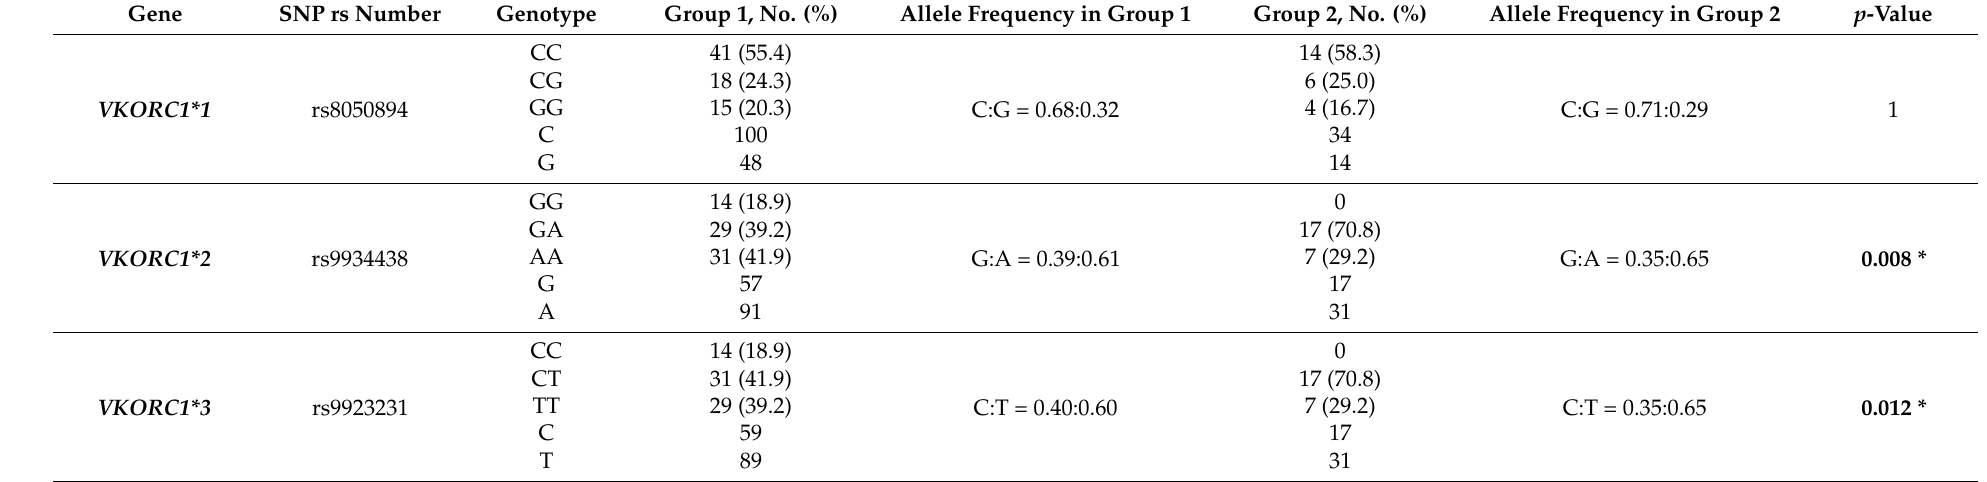
Table 5. The distributions of allelic and genotype frequencies of 21 SNPs between HF patients with/without